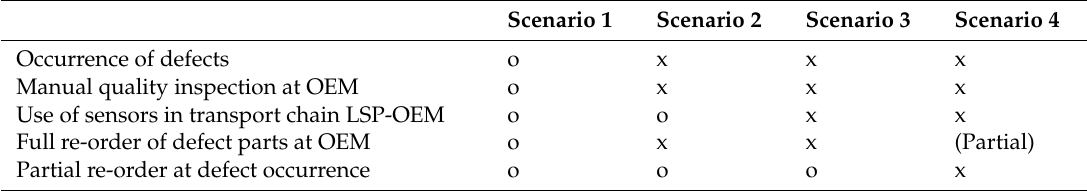
Table 6. Configuration summary of scenarios 1–4. (Legend: o = no, x = yes).